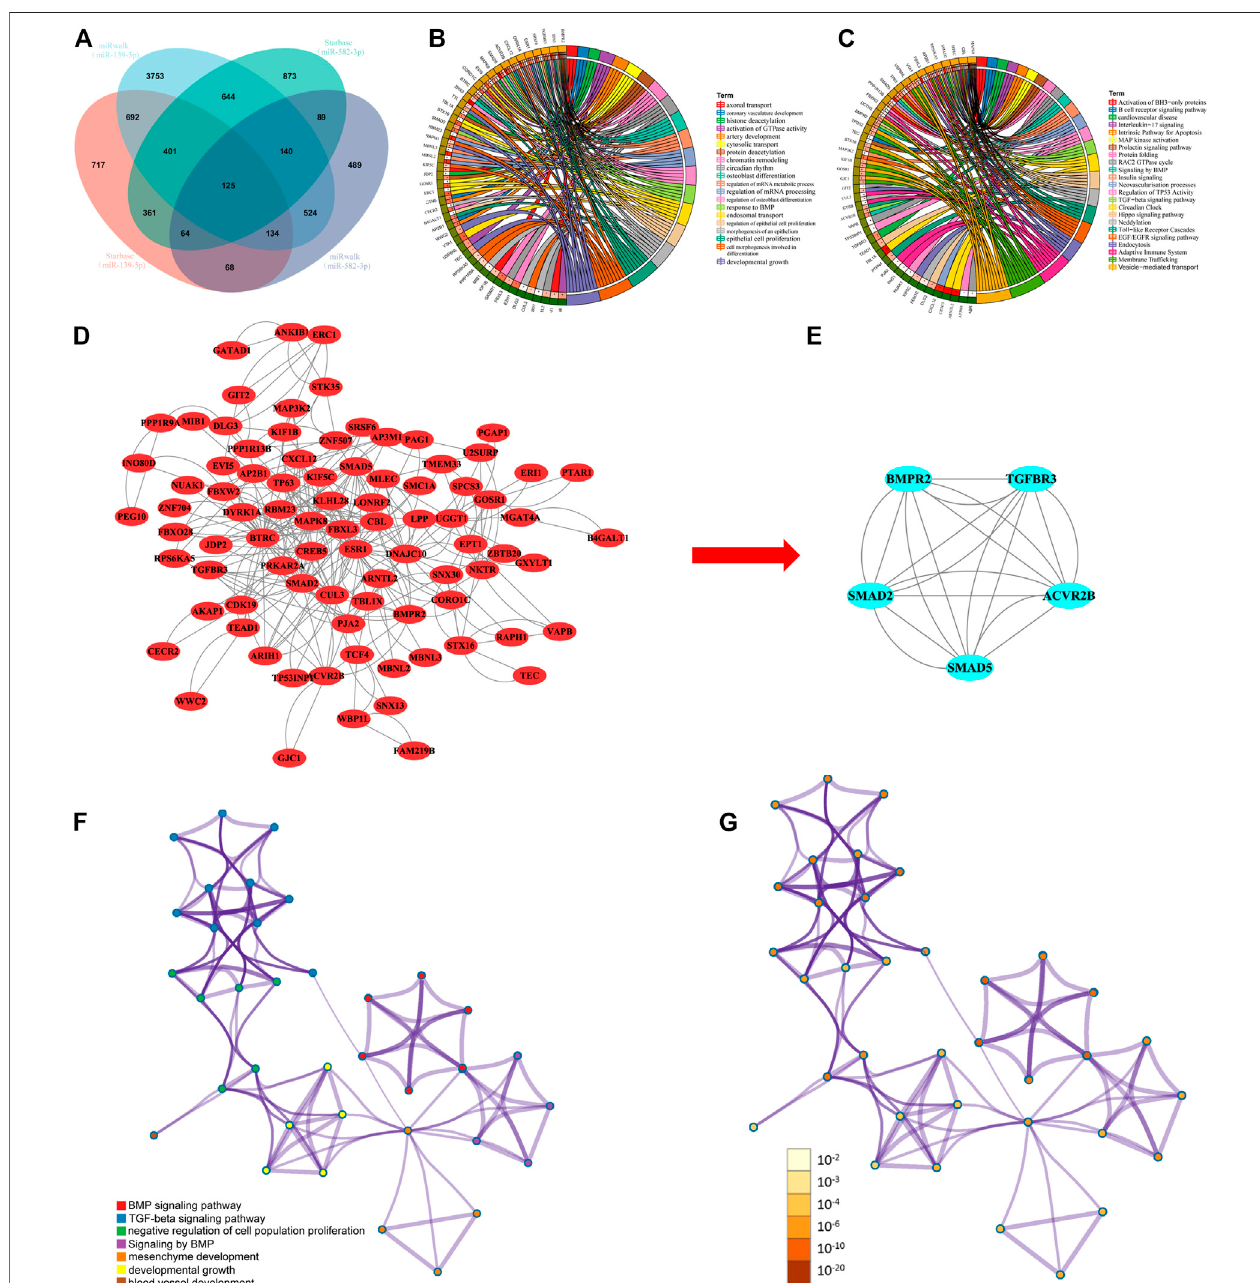
FIGURE 3 | (A) Venn diagram showing the overlapping target genes of miR-139-5p and miR-582-3p. (B) and (C) GO and KEGG analyses of overlapping target genes. (D) PPIanalysisofoverlappingtargetgenes. (E) HubnetworkscreeninginthePPIcoexpressionnetworkbytheMCODEplug-in. (F) and (G) Networkofenriched terms: (F) coloredbyclusterID, wherenodes thatshare thesameclusterIDaretypicallyclosetoeach other; (G) coloredbypvalue, wheretermscontainingmoregenes tend to have a more signi fi cant p value.